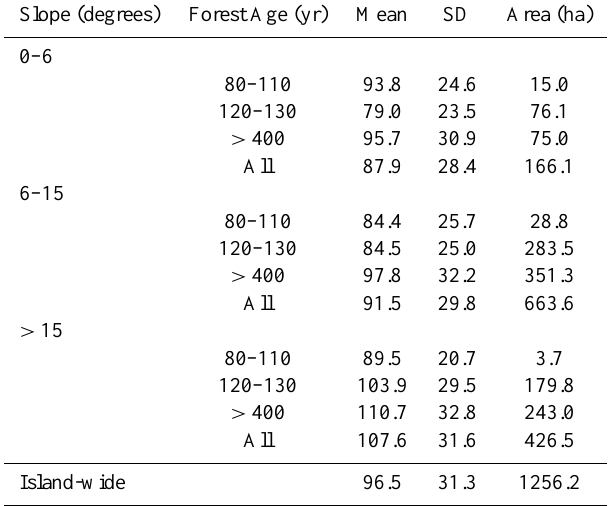
Table 3. Mean and standard deviation (SD) aboveground carbon density (Mgha − 1 ) values for different slope and forest age classifi- cations on BCI,